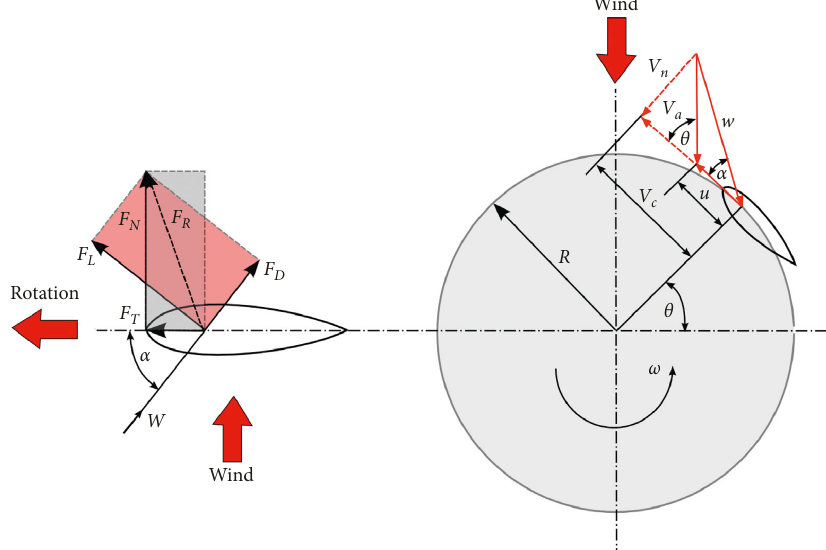
Figure 2: Velocities and forces distributions of Darrieus turbine airfoils.